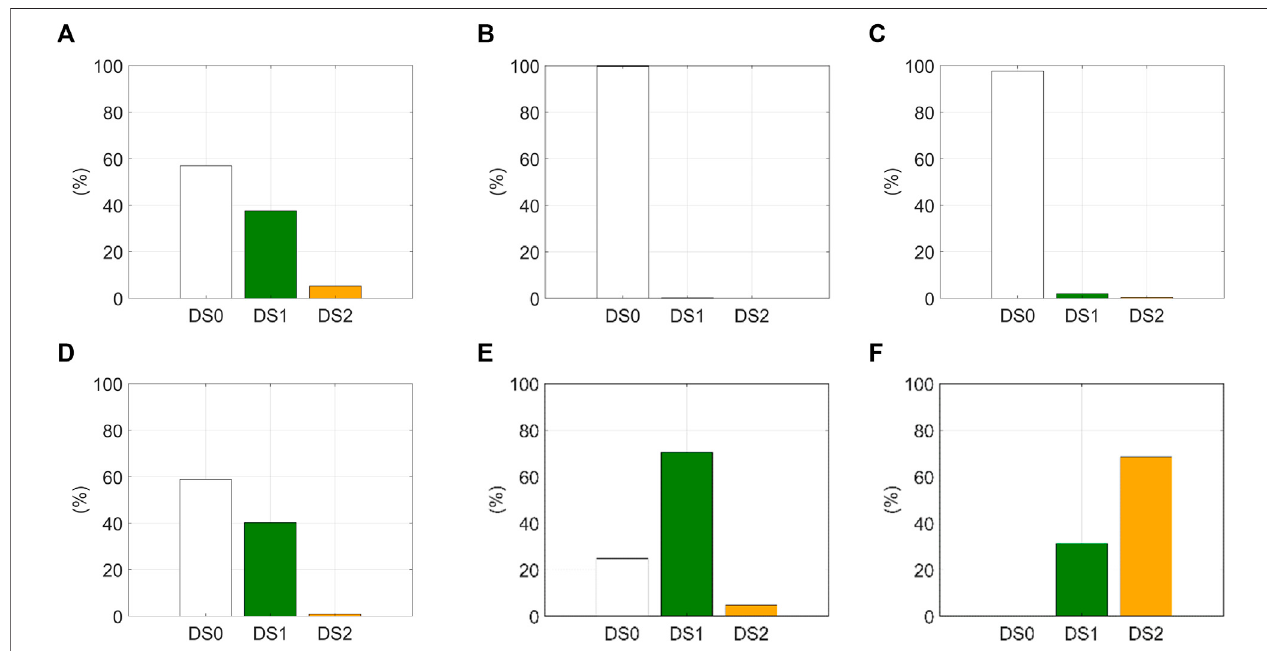
FIGURE12| Distributionofdamagefor (A) totaldataset, (B) one-storeybuildings, (C) two-storeybuildings, (D) three-storeybuildings, (E) four-storeybuildings, (F) fi ve plus – storey buildings obtained from FAST-NEPAL analysis.